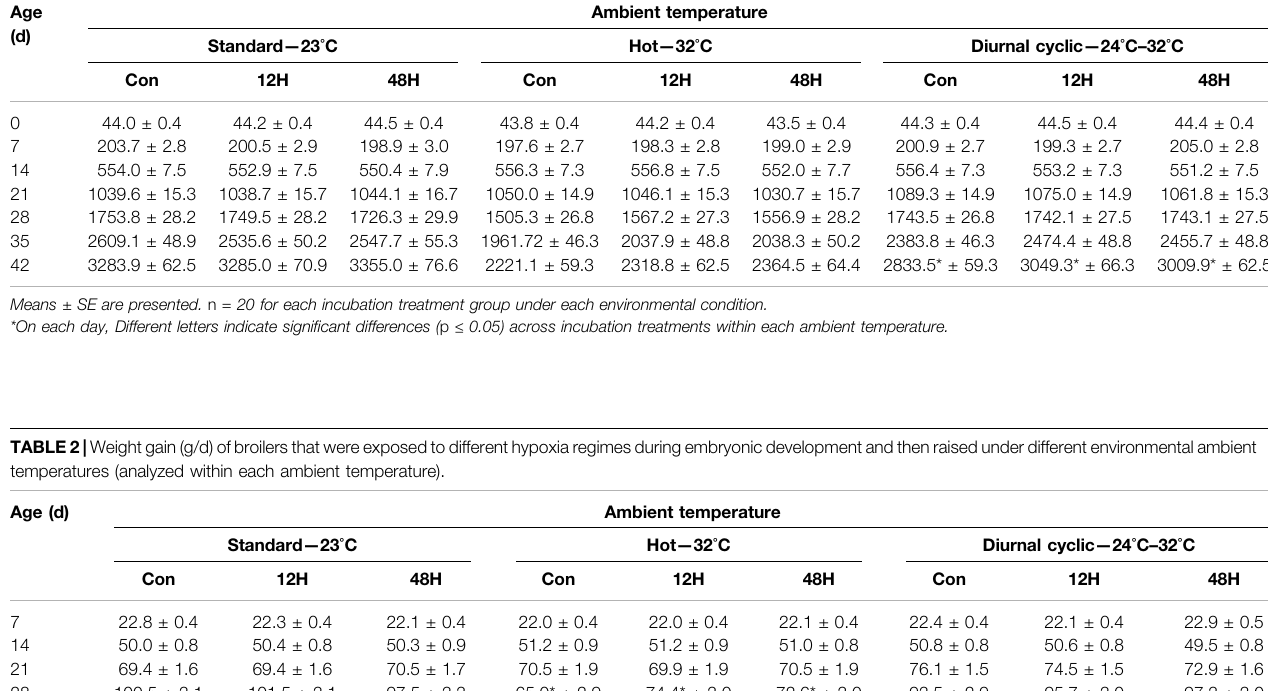
TABLE 1 | Body weight (g) of broilers exposed to different hypoxia regimes during embryonic development and then raised under different environmental ambient temperatures (analyzed within each ambient temperature). Age (d)